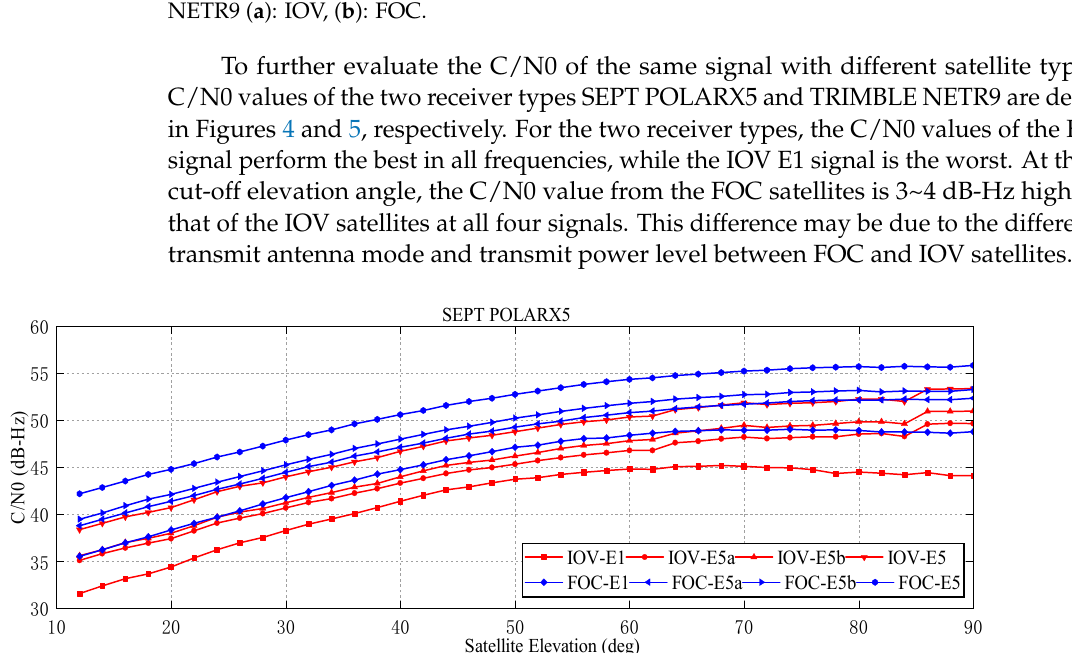
Figure 4. C/N0 values of the different types of satellites against the satellite elevation for the receiver SEPT